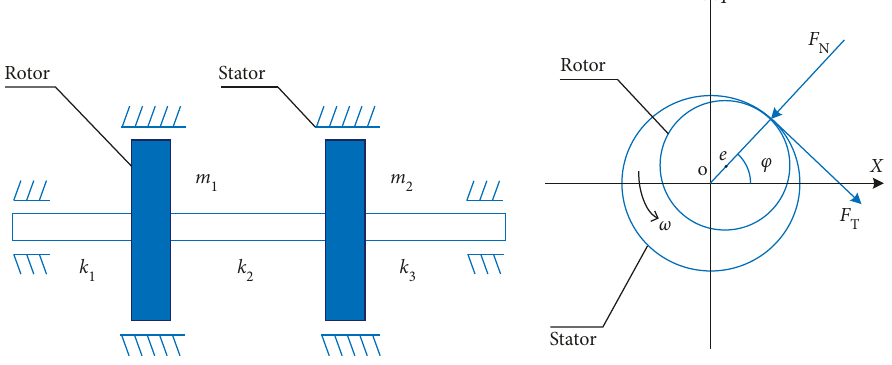
Figure 1: Two-span rotor-bearing